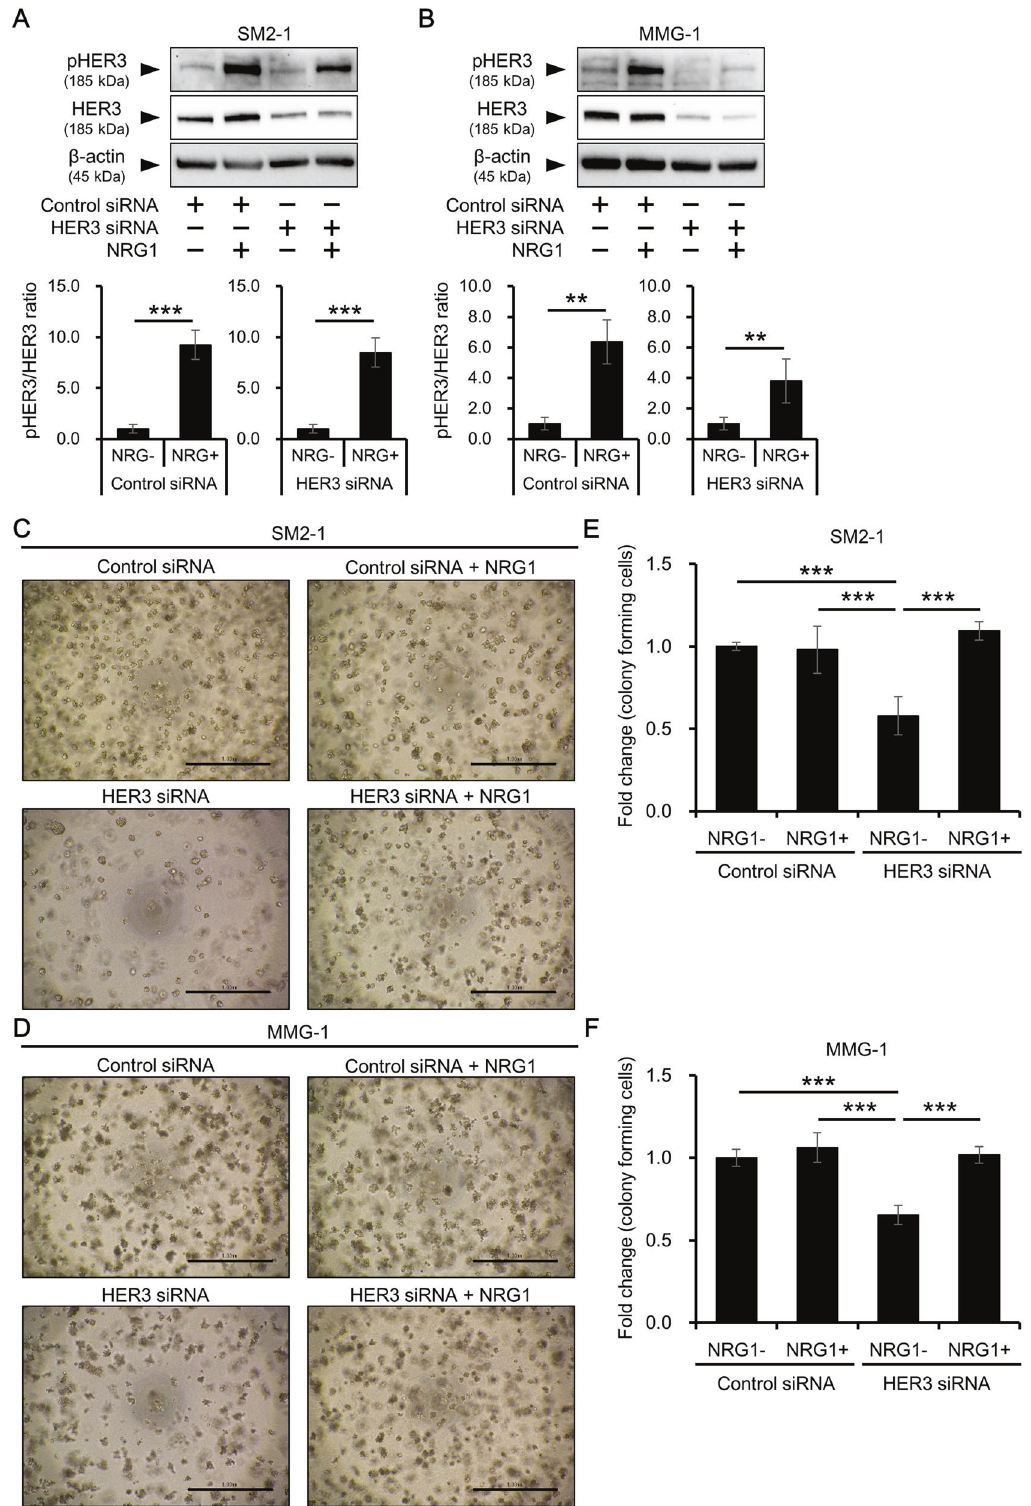
Fig. 4 Effects of HER3 reactivation by NRG1 on the anchorage-independent growth of AM cells. AM cells were transfected with control or HER3 siRNA in the presence of vehicle control or NRG1 (10 ng/ml) and evaluated for colony formation/anchorage-independent growth. Status of HER3 phosphorylation in ( A ) SM2-1 and ( B ) MMG-1 cells was determined. β -actin was also measured as a loading control. Experiments were independently repeated three times. Representative blot images (upper) and mean ± SD of pHER3/HER3 ratio (lower) are shown. Original uncropped blot images are shown in Supplementary Fig. S5. ** p < 0.01 and *** p < 0.001. Representative images of ( C ) SM2-1 and ( D ) MMG-1 cells cultured in semisolid agar layers. Scale bars = 1.0 mm. E , F The colonies formed in the agar layers were collected and quanti fi ed by MTT assay. Experiments were independently repeated three times and mean ± SD of fold change of absorbance relative to the control siRNA- transfected condition in ( E ) SM2-1 and ( F ) MMG-1 cells is shown. *** p < 0.001. Cell Death Discovery (2023)